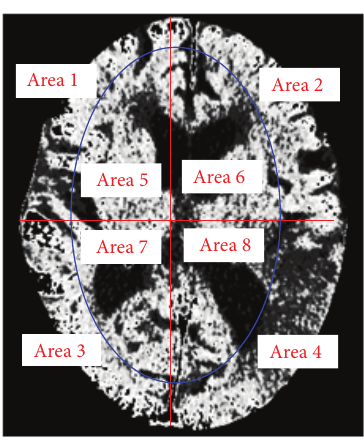
Figure 7: Image showing region